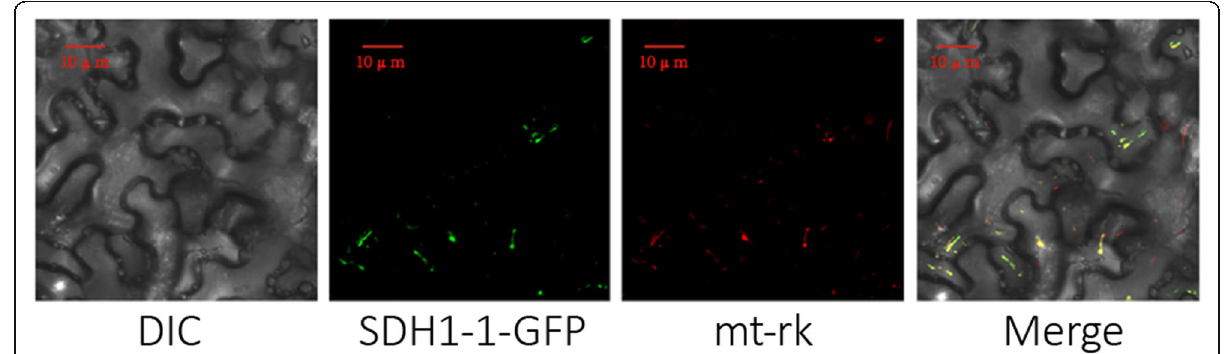
Fig. 6 Co-localization of SDH1 – 1-GFP with mitochondria